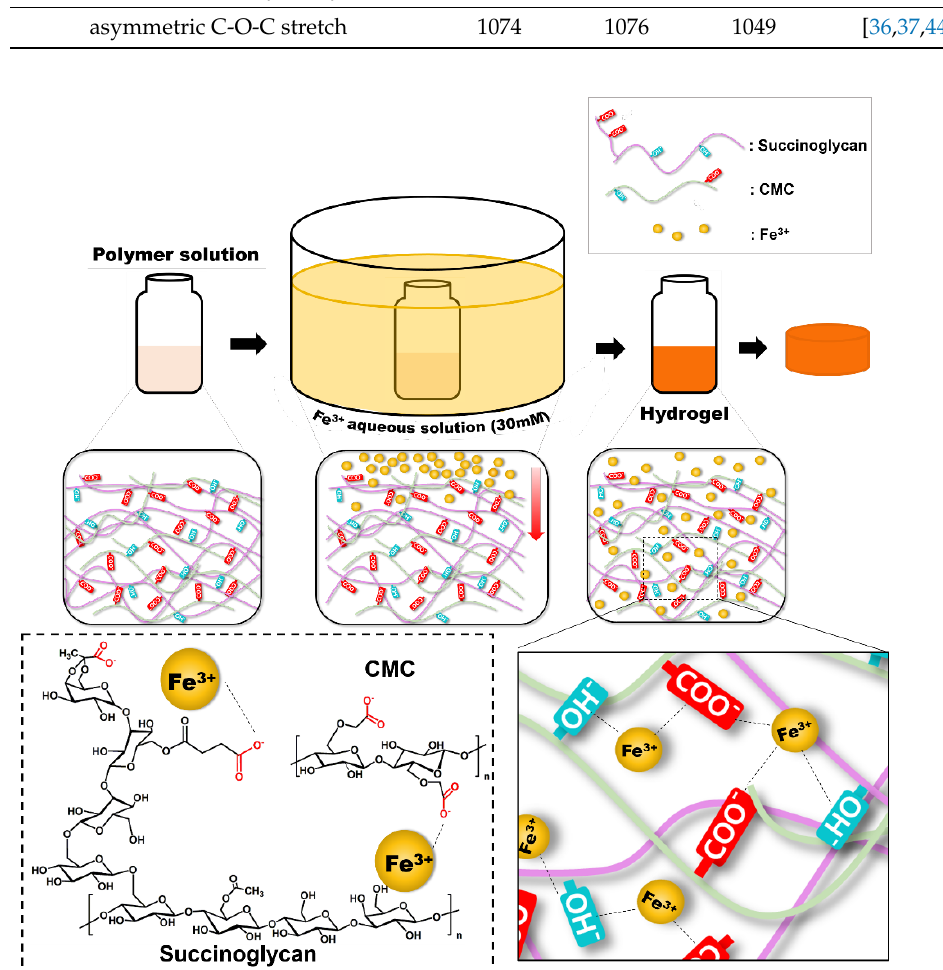
Figure 2. Schematic illustration of model of SG/CMC IPN hydrogels formation mechanism.